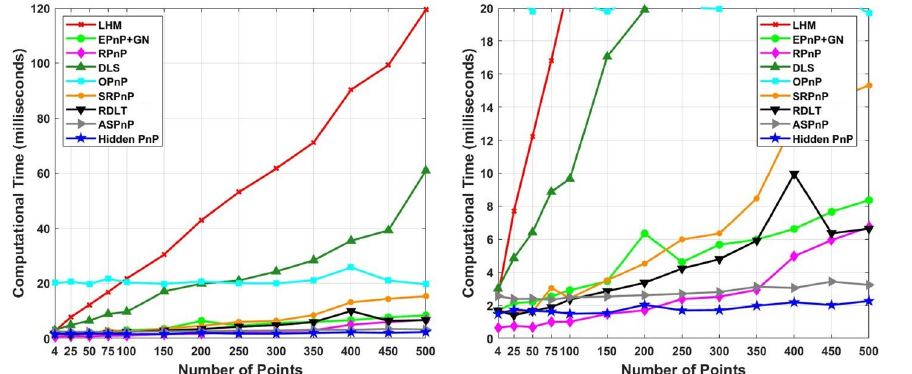
Figure 9. Comparison of the average running time of the PnP algorithm when the number of spatial reference points n ranged from 4 to